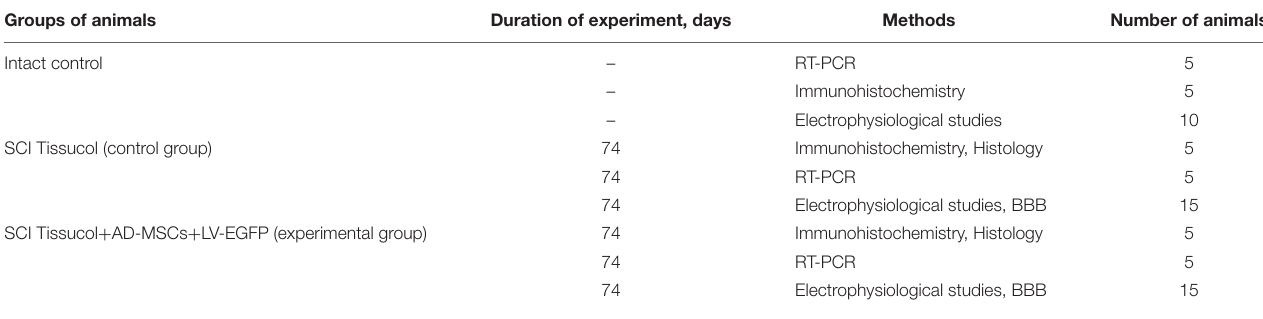
TABLE 1 | Investigated